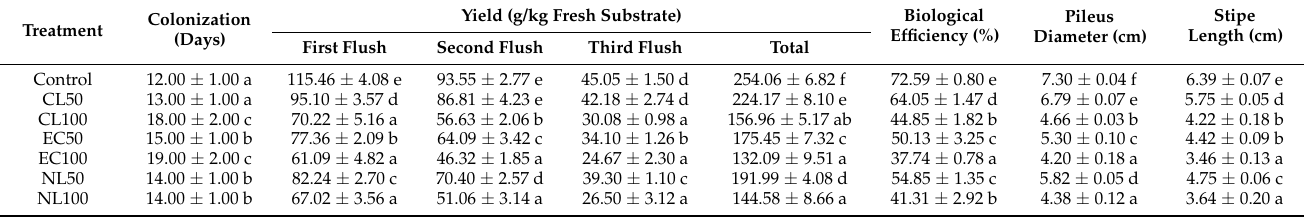
Table 2. Effect of wetland plant biomass on growth and yield properties (mean ± SD of five replicates) of P. florida .